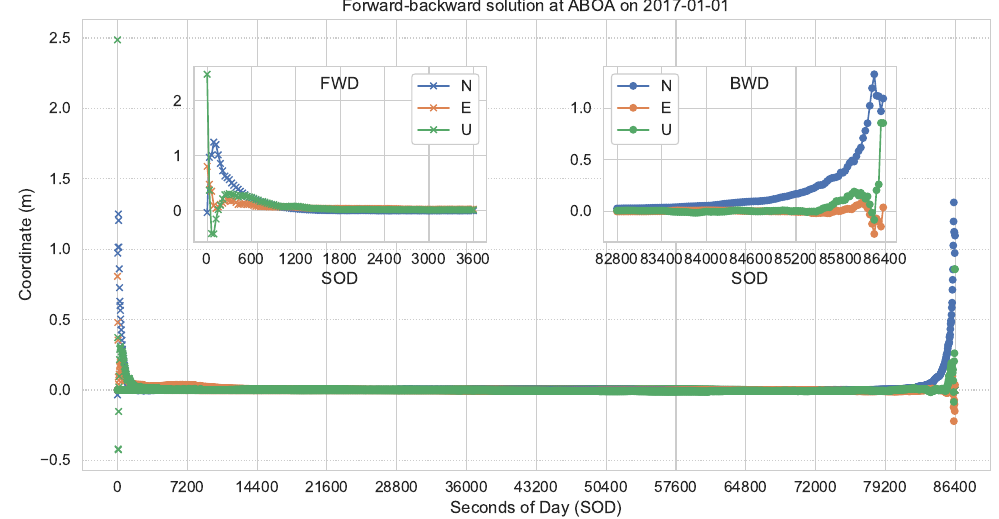
Figure 4. Convergence time for the PPP forward (FWD) and backward (BWD) solutions at Aboa on 1 January 2017.